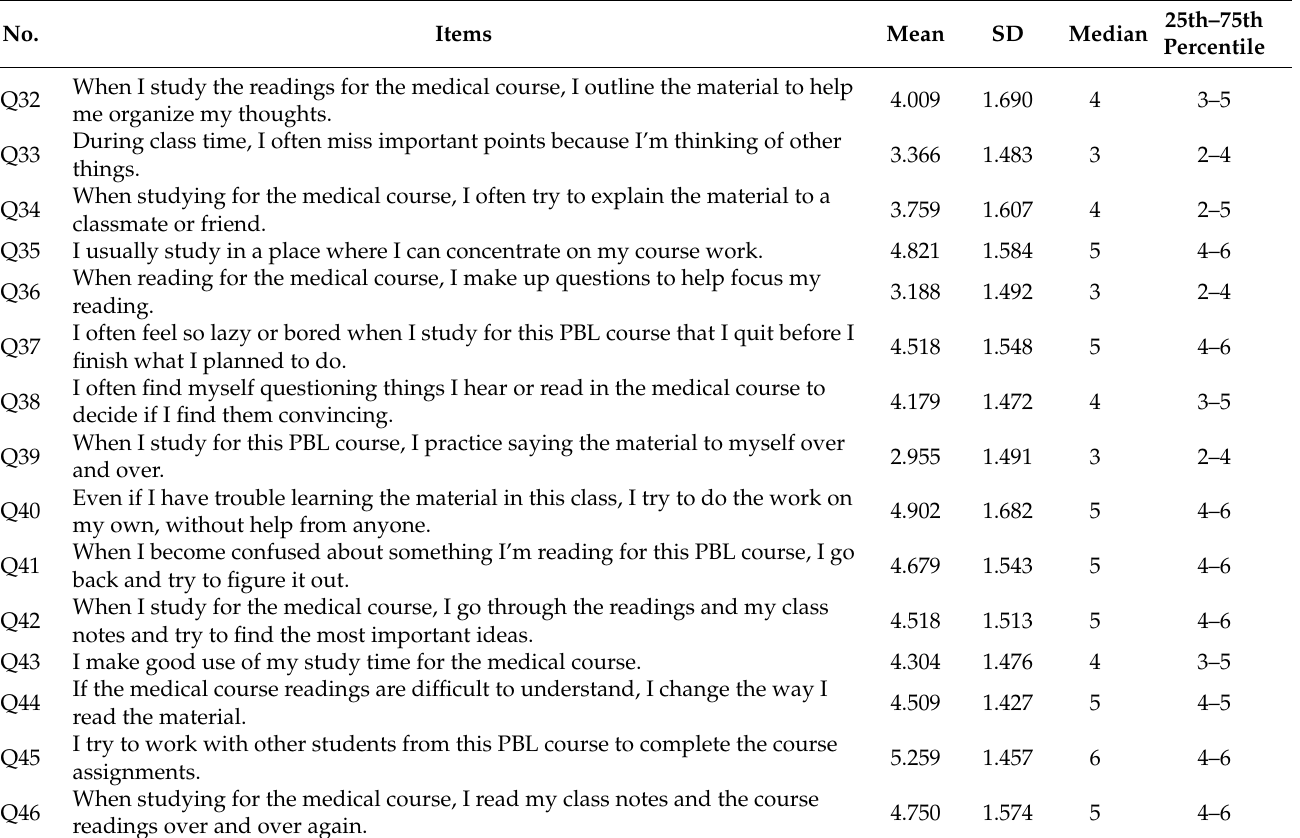
Table 2. Descriptive statistics of the Learning Strategies